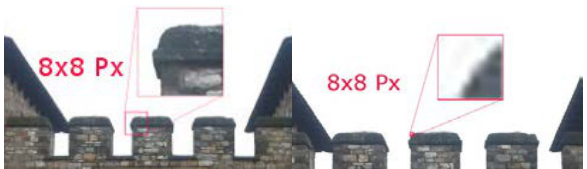
Figure 2. Excerpt of the camera view image with highlighted patch: left 8x8 pixel patch (400x300px), right 8x8 pixel patch (1600x1200px), (Kampa et. al., 2014)